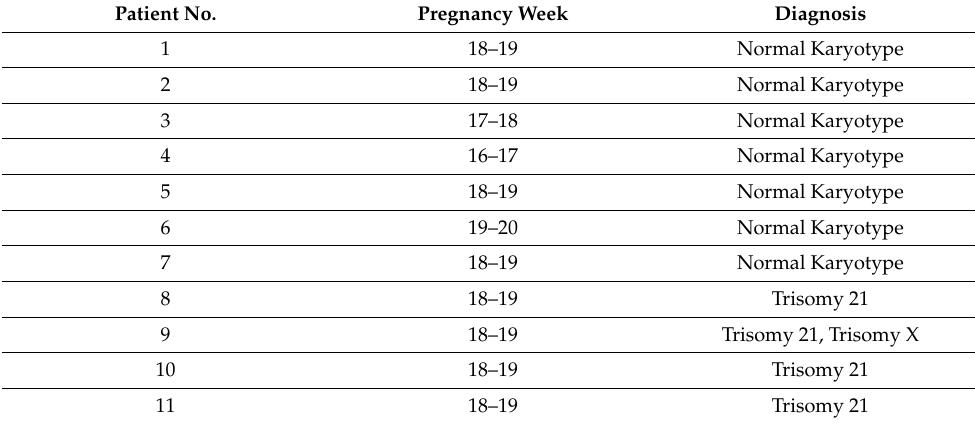
Table 1. Characteristics of patients enrolled for the